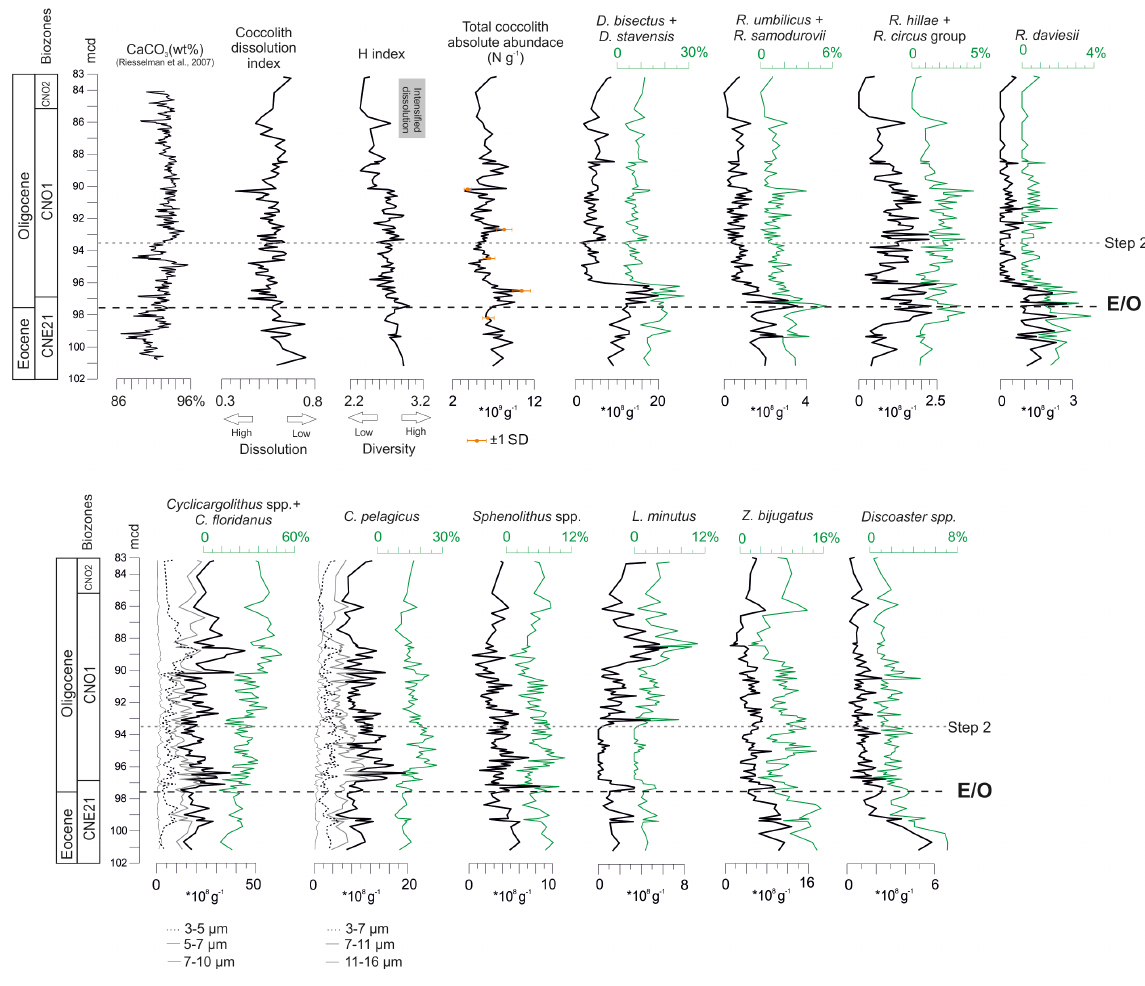
Figure 3. Calcareous nannofossil abundance and distribution against depth (mcd) at Site 1263 (data set A). CaCO 3 (wt%; Riesselman et al., 2007), coccolith dissolution index (%), H index, and the total absolute coccolith abundance (Ng − 1 ). Error bars indicates the standard deviation ( ± 1SD, in %) of replicate counts. The absolute (Ng − 1 , black line) and relative (%, green line) abundances of the main species constituting the assemblage are shown. For Cyclicargolithus spp. and C. pelagicus the absolute abundances of different size groups are shown. The grey vertical bar marks an interval of major dissolution (87 to 83mcd). The positions of EOB and Step 2 are